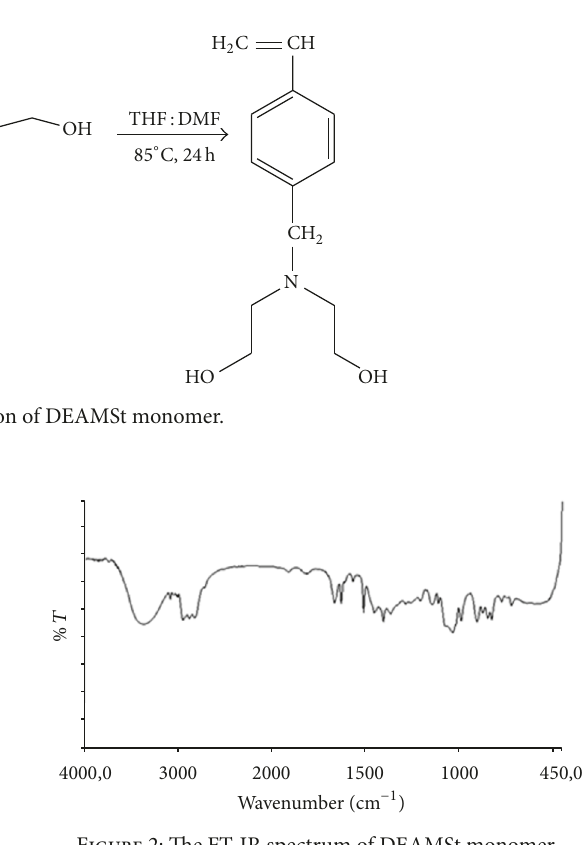
Figure 2: The FT-IR spectrum of DEAMSt